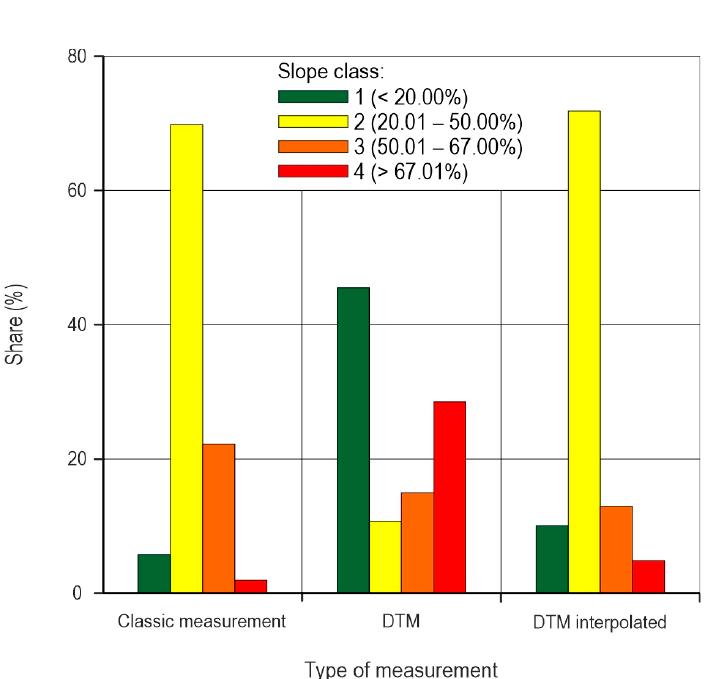
Figure 3. Share of slope class according to type of measurement.